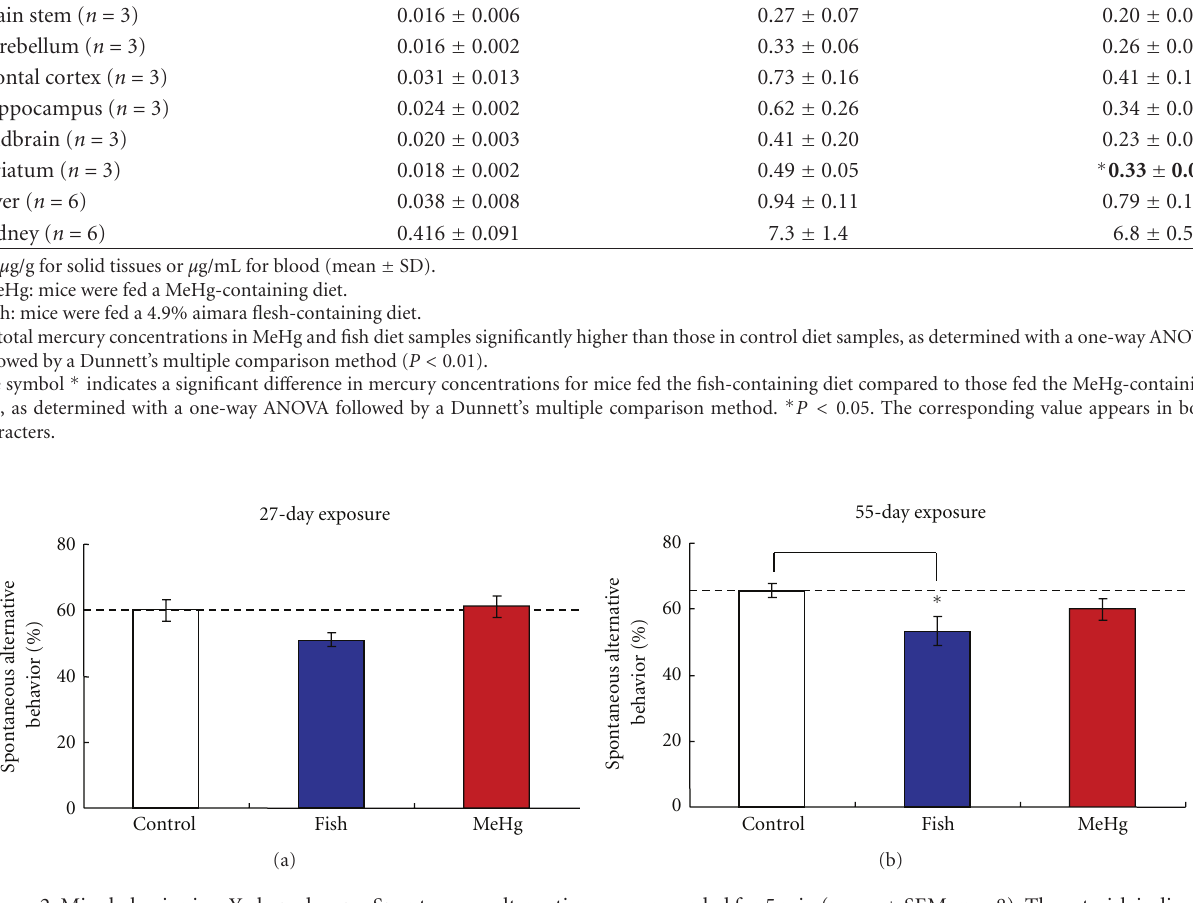
Figure 2: Mice behavior in a Y-shaped maze. Spontaneous alternations were recorded for 5min (mean ± SEM, n = 8). The asterisk indicates a significant di ff erence between the spontaneous alternations presented in the Y maze by mice fed the fish-containing diet compared to those fed the control diet, as determined with a one-way ANOVA followed by a Dunnett’s multiple comparison method, ∗ P < 0 . 05, and ∗∗ P < 0 .